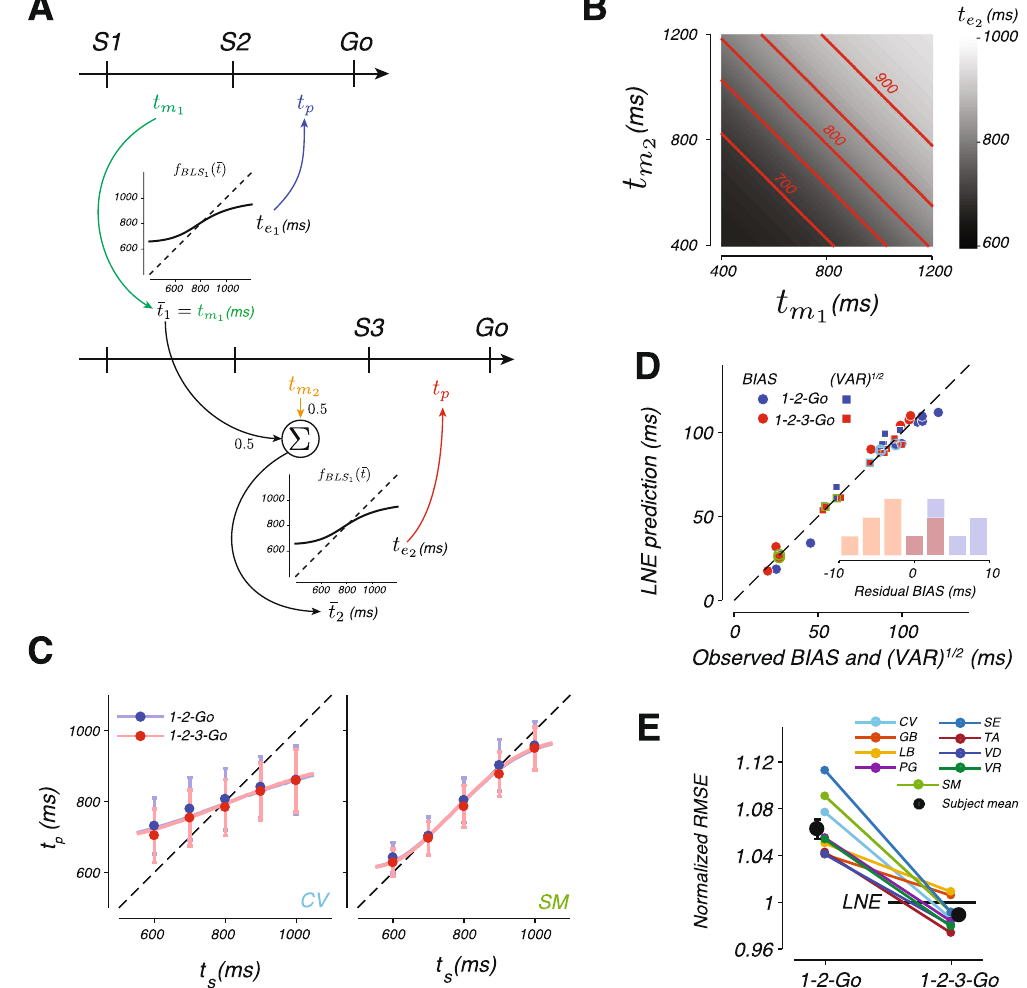
Figure 5. A linear-nonlinear estimator (LNE) model and its fits to the data. ( A ) LNE algorithm. LNE derives an estimate by applying a nonlinear function, f , to the average of the measurements. In the 1-2-Go trials (top), BLS 1 the average, t , is the same as the first measurement, t , and the estimate, t , is f t ( ) . In 1-2-3-Go trials 1 m 1 e 1 BLS 1 1 (bottom), the average, t , is updated by the second measurement, t ( t ), and the estimate, t , is 2 m 2 e 2 . In both conditions, the produced interval, t p , is perturbed by zero-mean Gaussian noise with standard deviation proportional to the final estimate ( t for 1-2-Go and t for 1-2-3-Go) with the constant of e 1 e 2 proportionality w p , as in the BLS model. ( B ) The mapping from measurements to estimates (grayscale) for the LNE estimator in the 1-2-3-Go trials. Red lines indicate combinations of measurements that lead to identical = 700, 750, 800, 850, and 900 ms). ( C ) Mean and standard deviation of t estimates (shown for t p as a function of e 2 t s for two example subjects (circles and error bars) along with the corresponding fits of the LNE model (lines). ( D ) BIAS (circles) and VAR (squares) of each subject (abscissa) and the corresponding values computed from simulations of the fitted LNE model (ordinate). Conventions match Fig. 4B. ( E ) The RMSE in the 1-2-Go and 1-2-3-Go conditions relative to the corresponding predictions from the LNE model (conventions as in Fig. 4C). See also Supplementary Figs 2, 3, 7, and